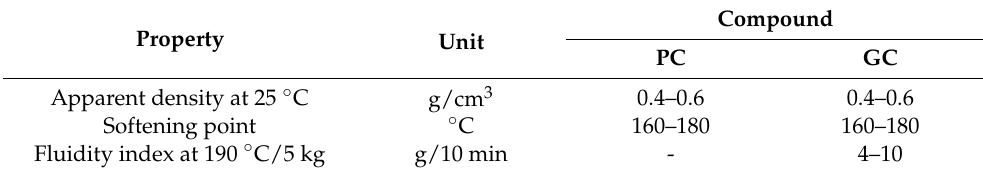
Figure 1. Plastomeric compounds: ( a ) PC-pellets; ( b ) GC-pellets. Fraction 0.50–1.00 mm after grinding and sieving: ( c ) PC; ( d ) GC. Table 2. Main properties of the